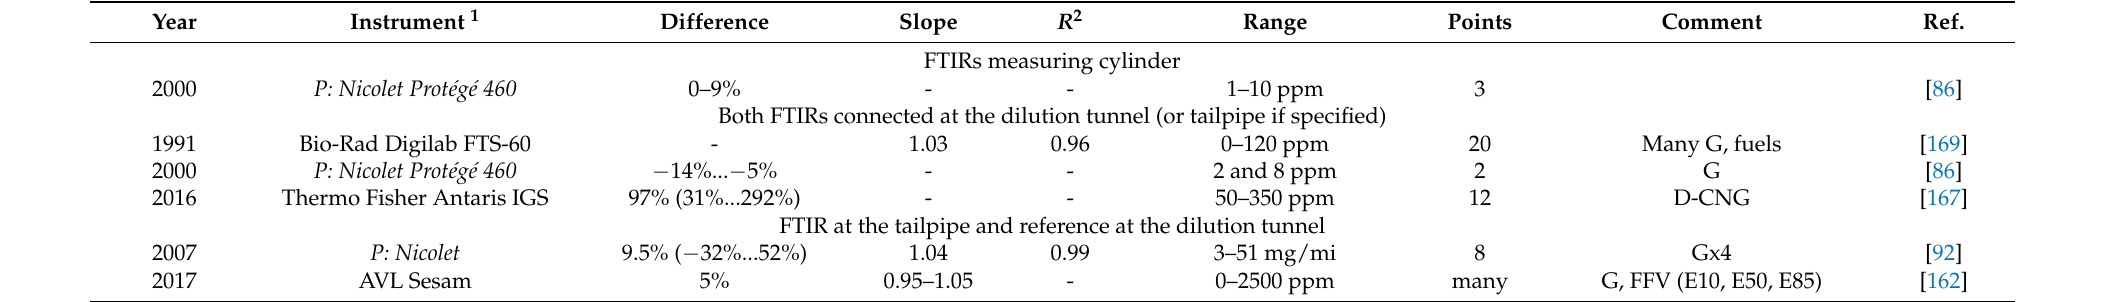
Table A7. Comparisons of FTIR with NMHC analyzers